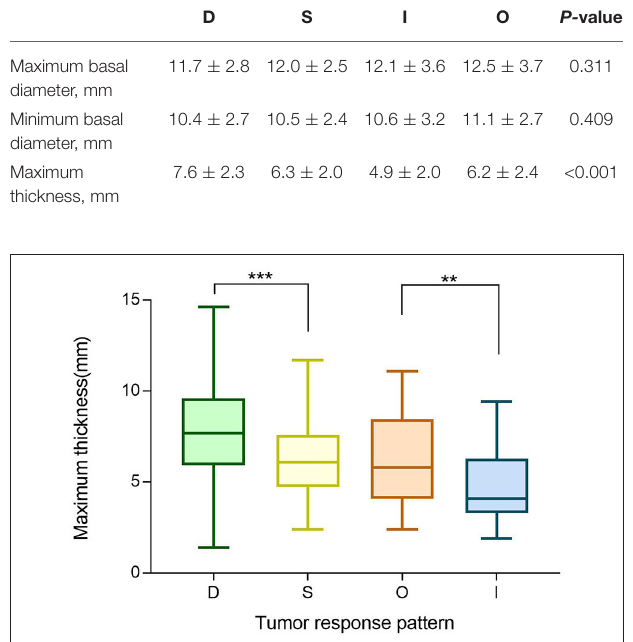
FIGURE 7 | Boxplot of preoperative maximum thickness of different tumor regression patterns (D vs. S vs. O vs. I). ** P ≤ 0.05, *** P <